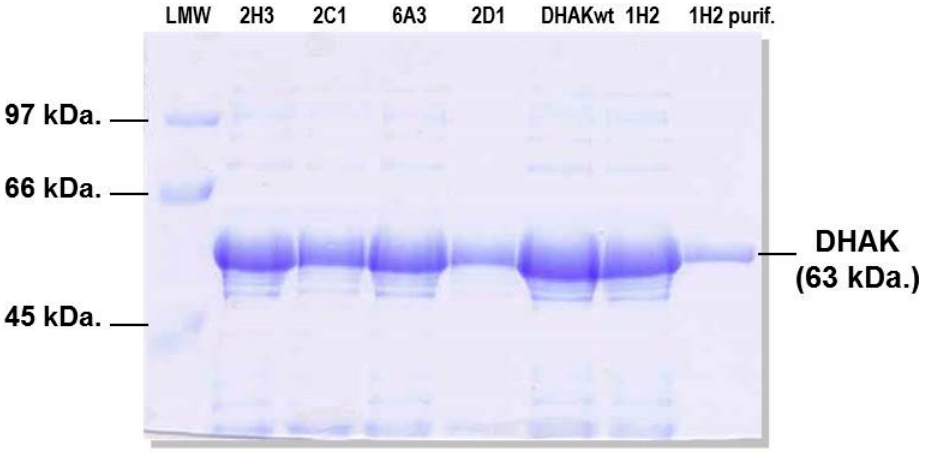
Figure 10. SDS-PAGE analysis of the expression of five mutants and the wild-type DHAK (DHAKwt). Left lane shows mutant 1H2 after purification.